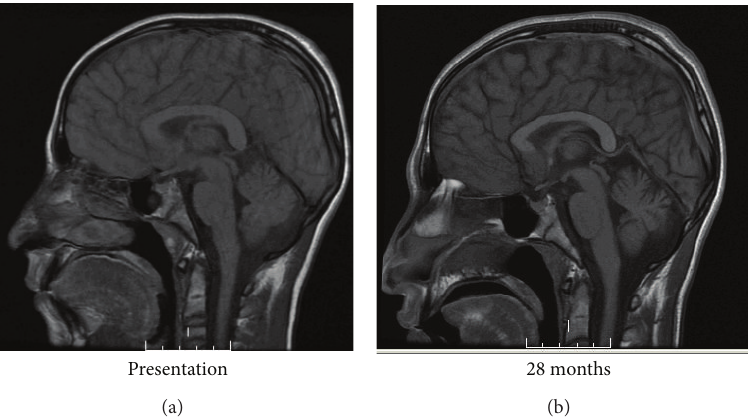
Figure 3: MRI demonstrates progressive atrophy of the corpus callosum, cortex, and cerebellum more than 2 years after the diagnosis of